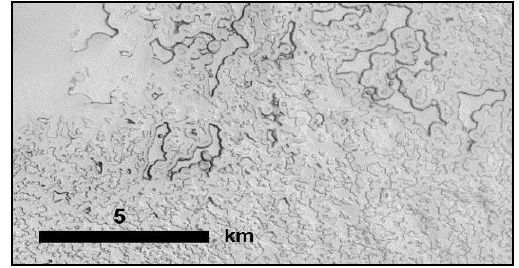
Figure 1: SCT Sublimation